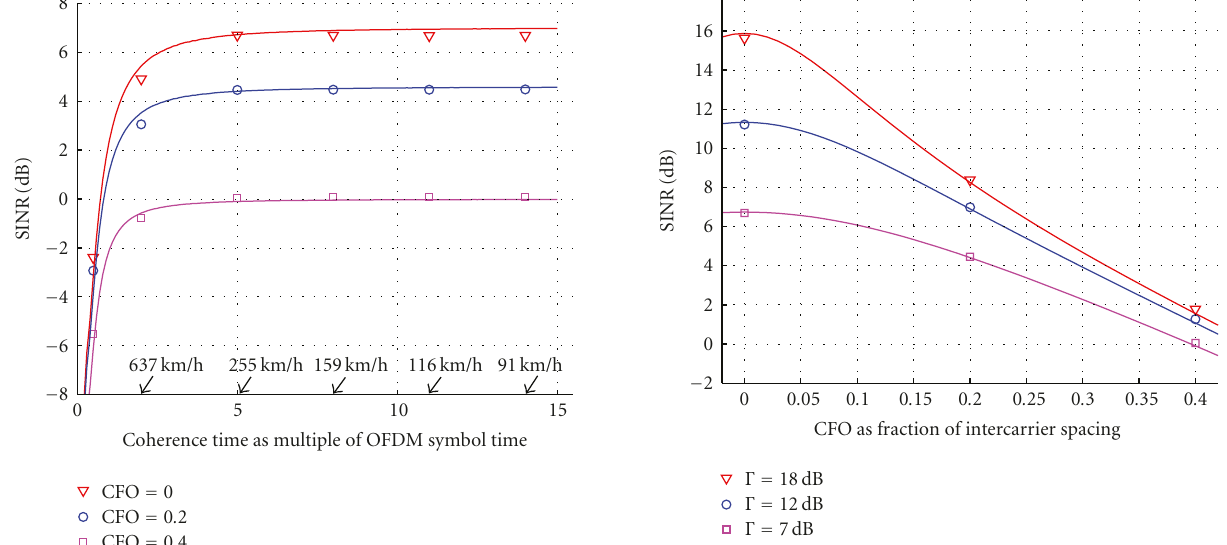
Figure 3: SINR for di ff erent carrier frequency o ff set as a function of channel coherence time. Solid curves are evaluations of (23) and markers represent simulation results. System parameters are as in Figure 1, SNR Γ = 7 dB.